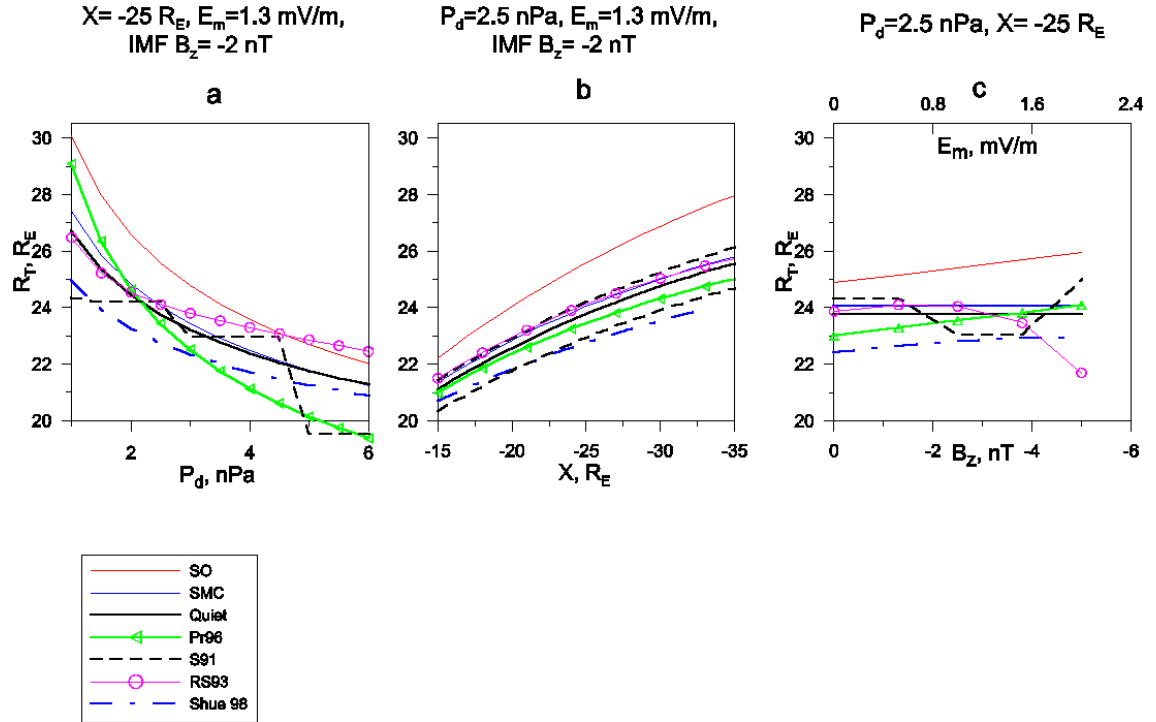
Fig. 2. Magnetotail radius dependence on P d , X , E m / B z for the present model compared with previous